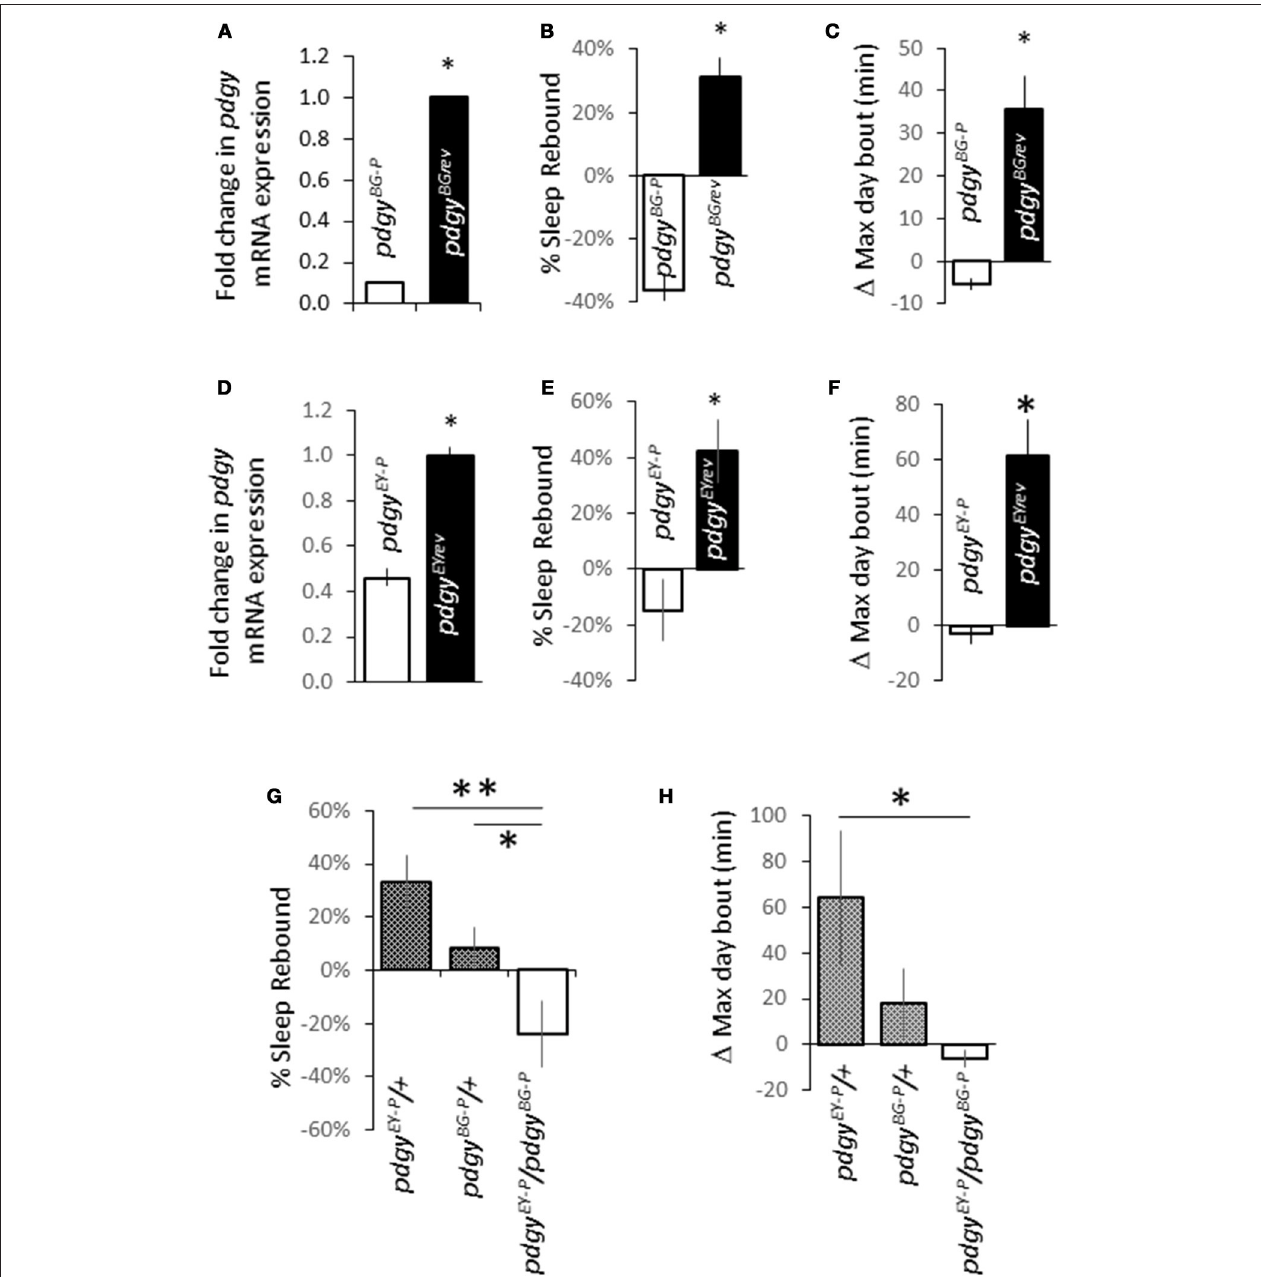
FIGURE 1 | Disruption in pdgy expression alters the response to sleep deprivation. (A) Levels of pdgy mRNA are decreased in pdgy BG 02662 ( pdgy BG − P ) flies compared to the background control, pdgy BGrev ( n = 3 groups of 5 pooled flies for each genotype, p < 0.05 by Students t -test). (B) The amount of sleep recaptured after sleep deprivation is significantly decreased when pdgy is disrupted ( n = 49 pdgy BG − P and n = 39 pdgy BGrev ). (C) The individual change in the maximum day bout was increased in the pdgy BGrev compared to the pdgy BG − P . (D) A second P-element near the pudgy BG − P insertion and in a different background, pdgy EY 02124 ( pdgy EY − P ) has decreased levels of pdgy RNA levels compared to the background controls, pdgy EYrev . (E) The sleep homeostatic response is muted in pdgy EY − P ( n = 40) compared to the background control pdgy EYrev ( n = 43). (F) The average increase in the maximum day bout is increased between the pdgy EY − P and the pdgy EYrev . (G,H) To determine if there was something in the background responsible for the sleep phenotype in the background of the two strains of flies, we ran a complementation test. pdgy EY − P / + ( n = 16) and pdgy BG − P / + ( n = 14) showed a positive response to sleep deprivation while the pdgy EY − P /pdgy BG − P ( n = 13) heterozygote has a significantly lower sleep rebound (G) and maximum day bout on the day following sleep deprivation (H) . * p < 0.05, ** p < 0.01.